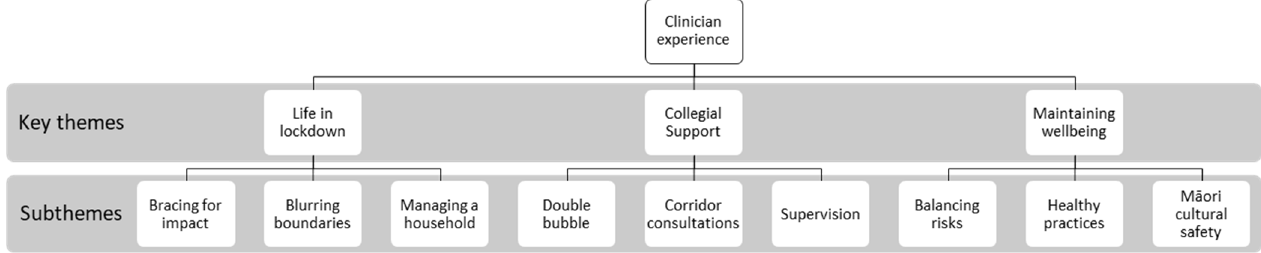
Figure 2. Common themes.